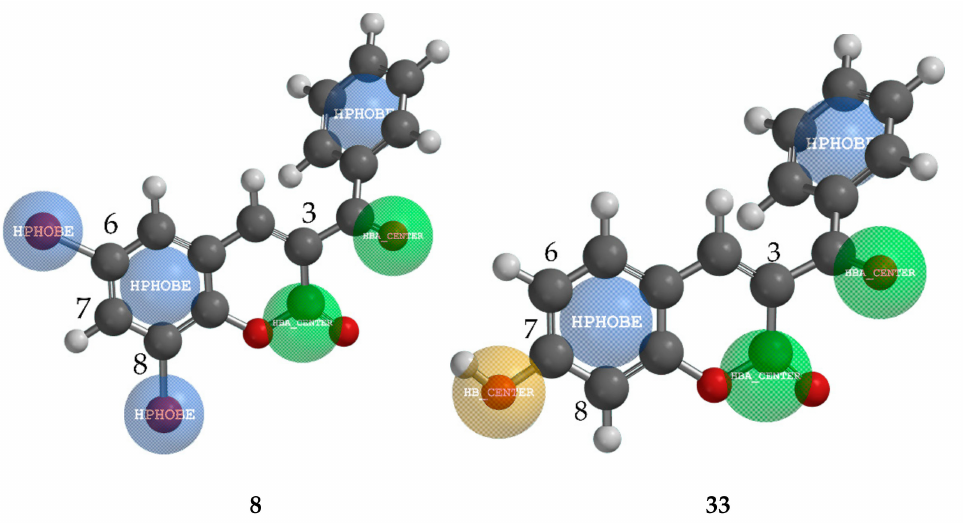
Figure 4. Pharmacophore mapping of one of the most active compounds 8 and one of the least active compound 33 against pathogen fungi S. sclerotiorum . (Green = hydrogen-bond acceptor; Blue = hydrophobe region; Brown = hydrogen-bond